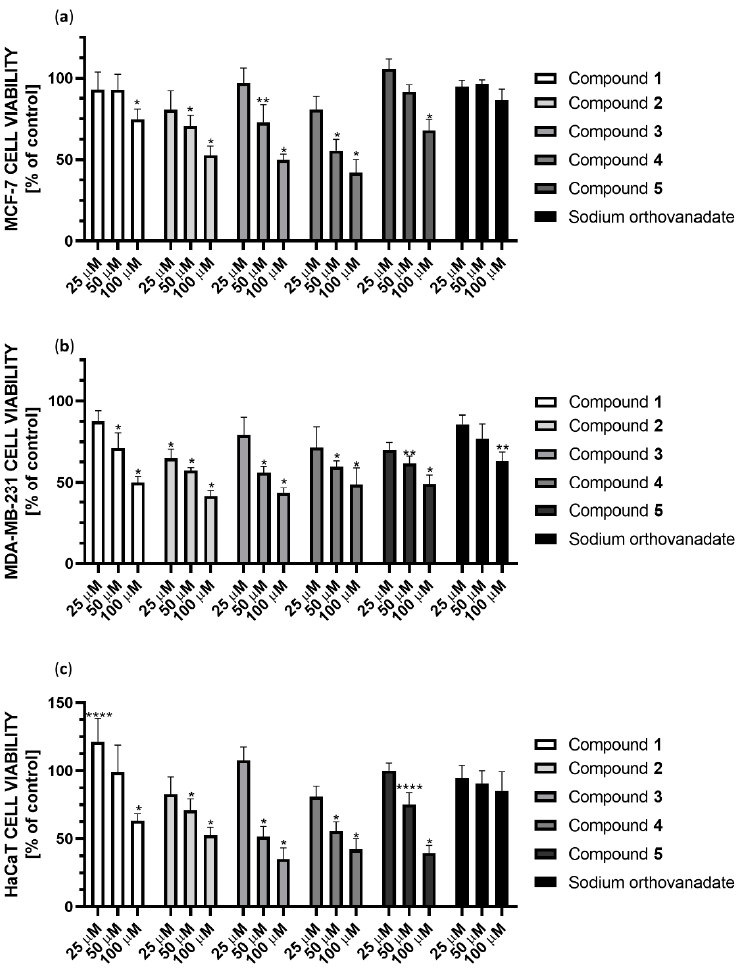
Figure 13. Cytotoxicity of Compounds 1 – 5 and sodium orthovanadate at concentrations 25, 50, and 100 μ M against ( a ) the breast cancer MCF ‐ 7 cell line; ( b ) the breast cancer MDA ‐ MB ‐ 231 cell line; ( c ) the human keratinocyte HaCaT cell line. Cell viability was measured by the MTT cell viability assay. The results were presented as a percentage of the control (mean ± SD, n = 3, * p < 0.0001; ** p < 0.001; **** p < 0.1).